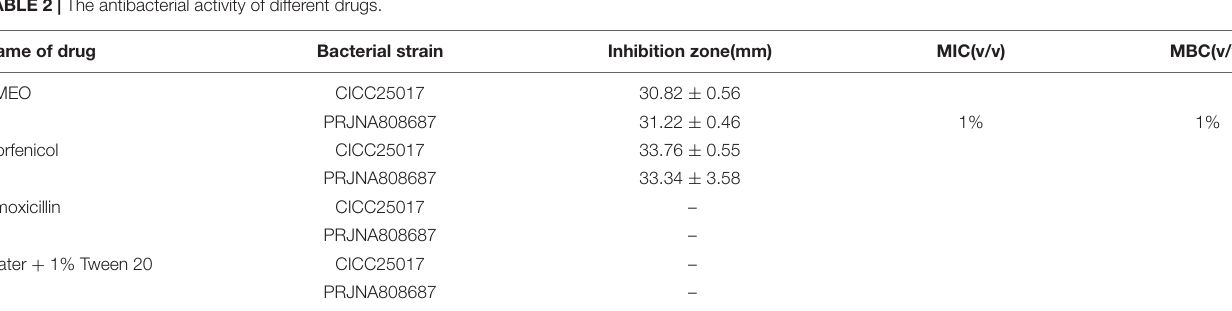
FIGURE 1 | The antibacterial activity of SMEO against Aeromonas hydrophila . (A) The diameter zone of inhibition (mm). (B) A. hydrophila growth curves with or without different concentrations of SMEO. TABLE 2 | The antibacterial activity of different